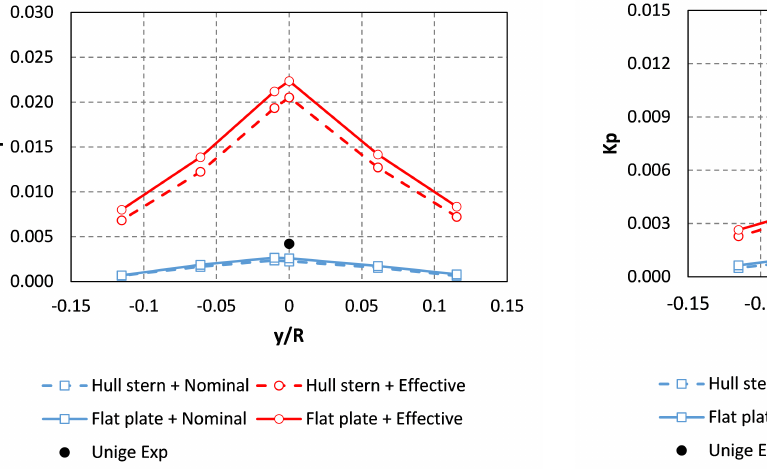
Figure A.1: Effect of the hull shape and of nominal and effective wakes in correspondence of different transversal point at longitudi- nal propeller plane position. Second harmonic values.